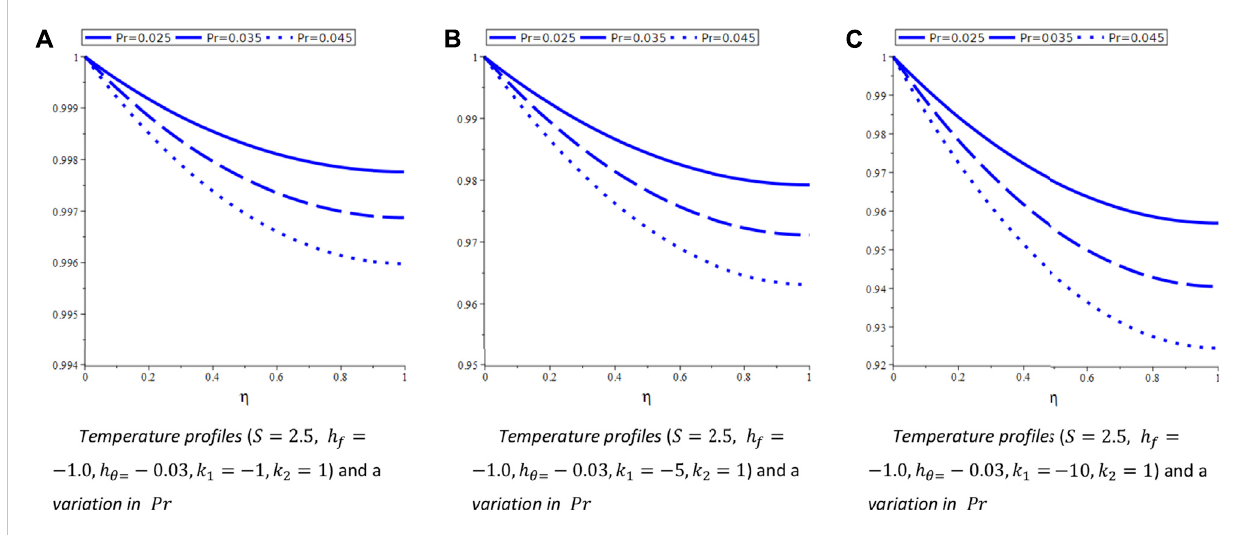
FIGURE 4 Different temperature pro fi les. (A) Temperature pro fi les ( S (cid:1) 2 . 5 , h f (cid:1) − 1 . 0 , h θ (cid:1) − 0 . 03 , k 1 (cid:1) − 1 , k 2 (cid:1) 1) and a variation in Pr . (B) Temperature pro fi les ( S (cid:1) 2 . 5 , h f (cid:1) − 1 . 0 , h θ (cid:1) − 0 . 03 , k 1 (cid:1) − 5 , k 2 (cid:1) 1) and a variation in Pr . (C) Temperature pro fi les ( S (cid:1) 2 . 5 , h f (cid:1) − 1 . 0 , h θ (cid:1) − 0 . 03 , k 1 (cid:1) − 10 , k 2 (cid:1) 1) and a variation in Pr .